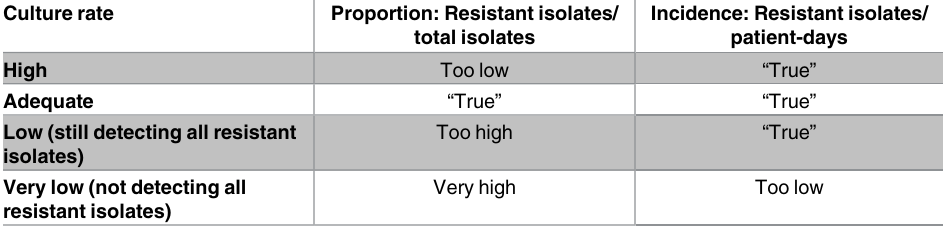
Table 1. Influence of culture rate on resistance proportions and resistance